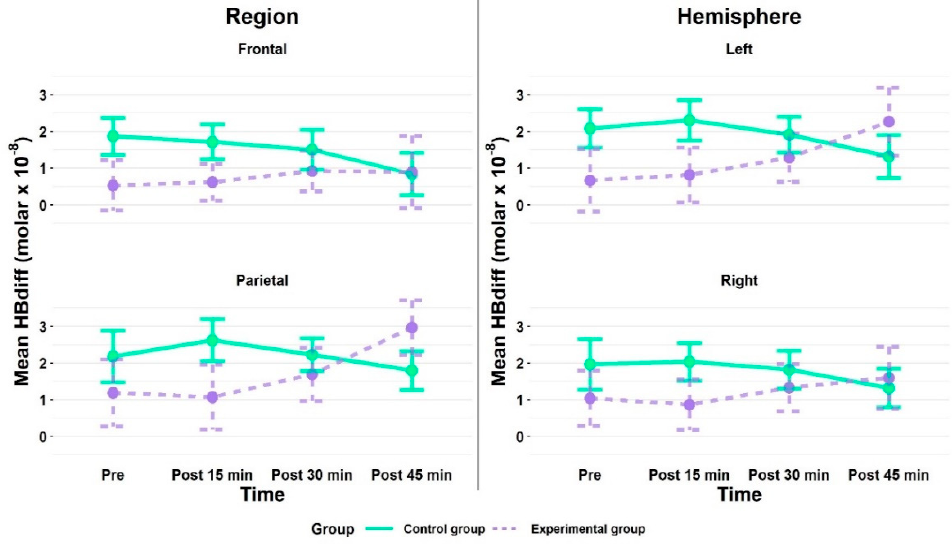
Figure 6. Mean cortical hemodynamic activity as measured by HBdiff in region (frontal, parietal) and hemisphere (left, right) during the 2-back task for the experimental (EG) and control group (CG) at time point pre (baseline) and at the follow-up measurements after the acute exercise intervention (EG) or listening to the audiobook (CG), respectively. All values are given as mean ( M ); error bars represent one standard error ( SE ) of the